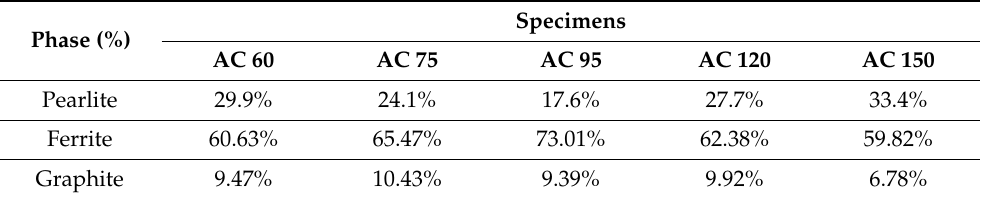
Table 2. Area fractions of different phases in the as-cast samples (%).